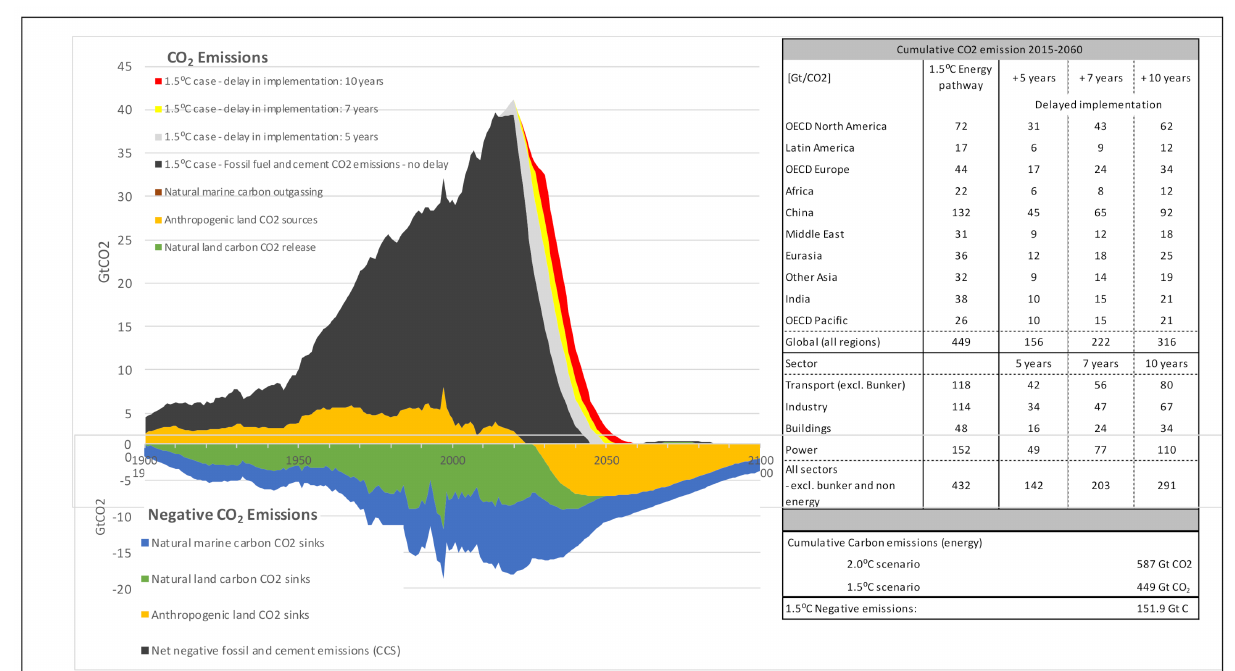
Figure 5. Annual and cumulative CO 2 emissions under the 1.5 ◦ C Scenario by region and sector; additional cumulative CO 2 emissions if implementation is delayed (5, 7, or 10 years); and carbon sinks from land, oceans, and additional land restoration. Additional cumulative CO 2 emissions by region and sector were calculated on the assumption that CO 2 emissions will remain flat for this region and/or sector for the corresponding time period. Annual emissions are compared between the 1.5 ◦ C pathway and the delayed implementation pathway, and the difference is summed over the entire period